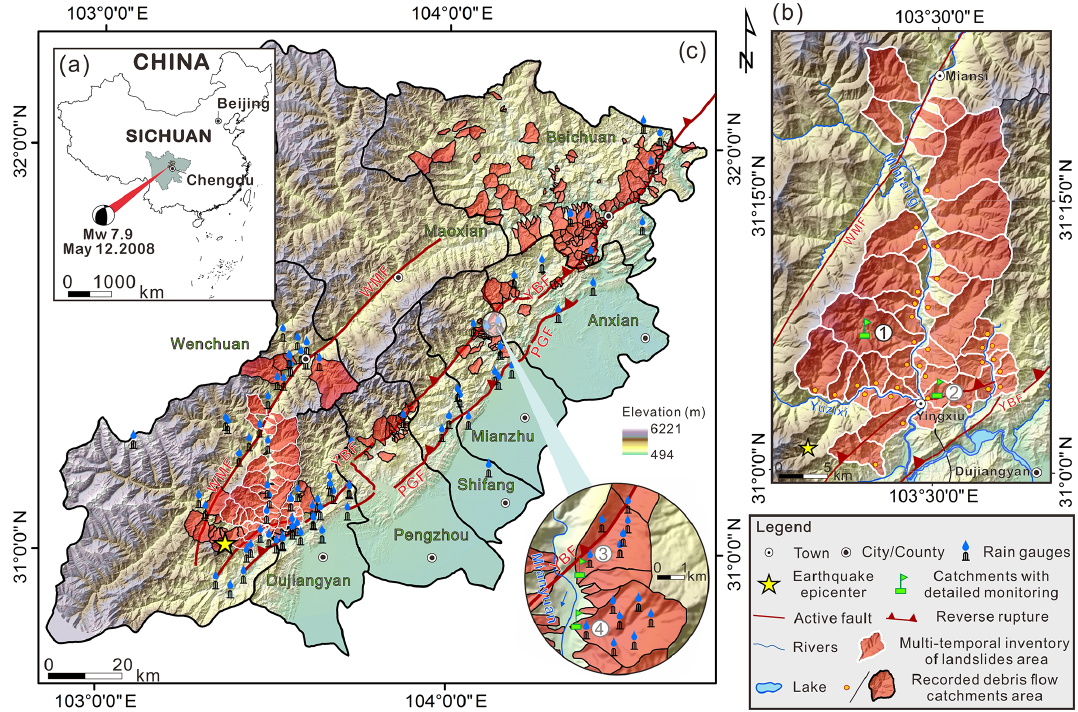
Figure 1. General view of the study area in Sichuan, China (a) . Detail of the area in which the multi-temporal inventory of landslides was carried out (b) . Detail of the area in which debris flows were recorded, with an indication of their location and those of the rain gauges (c) . Circled numbers (1–4) indicate well-monitored